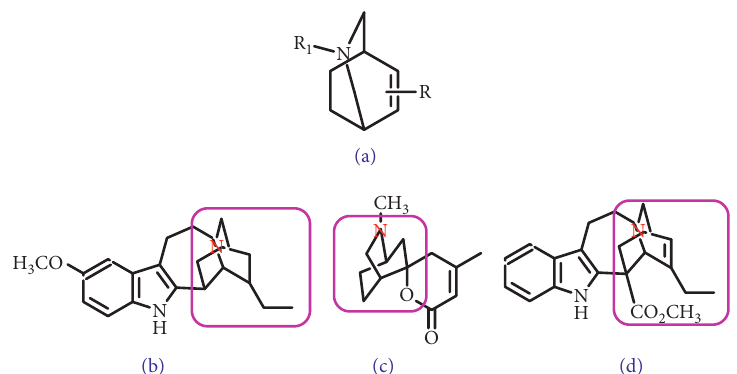
Figure 1: Natural product alkaloids isoquinuclidines (a), ibogaine (b), dioscorine (c), and catharanthine (vinca alkaloids) (d).